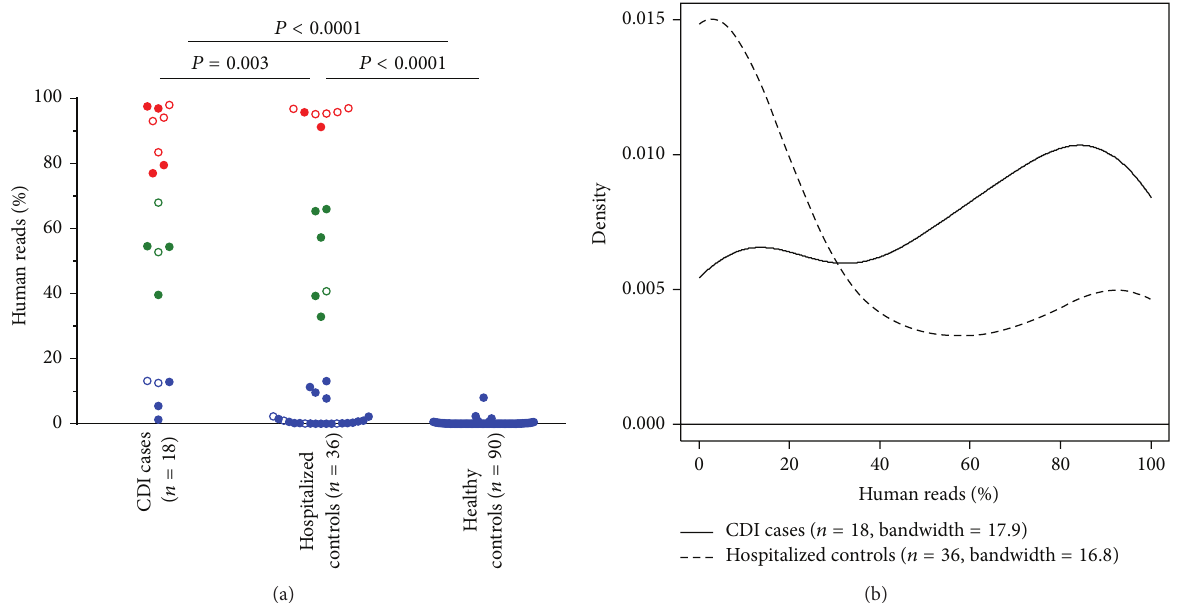
Figure 1: Distribution of human read proportions in fecal samples from CDI cases, hospitalized controls, and healthy subjects. (a) Scatter plot showing the proportions of human reads in each subject group. Patients admitted to the hospital for gastrointestinal problems (8 cases and 10 controls) are displayed as open circles. Three subgroups representing low ( < 30%, shown in blue), intermediate (30–70%, shown in green), and high ( > 70%, shown in red) amounts of human DNA were apparent from the sample distributions. 𝑃 values were determined by Mann-Whitney 𝑈 test. (b) Kernel density plot showing the distribution of human read proportions in CDI case and hospitalized control